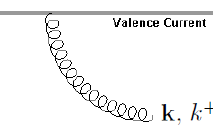
Figure 2 . Soft gluon emission with momentum k = ( k ; k + ) from a valence current (cid:26) at order g . The emission vertex is de(cid:12)ned by